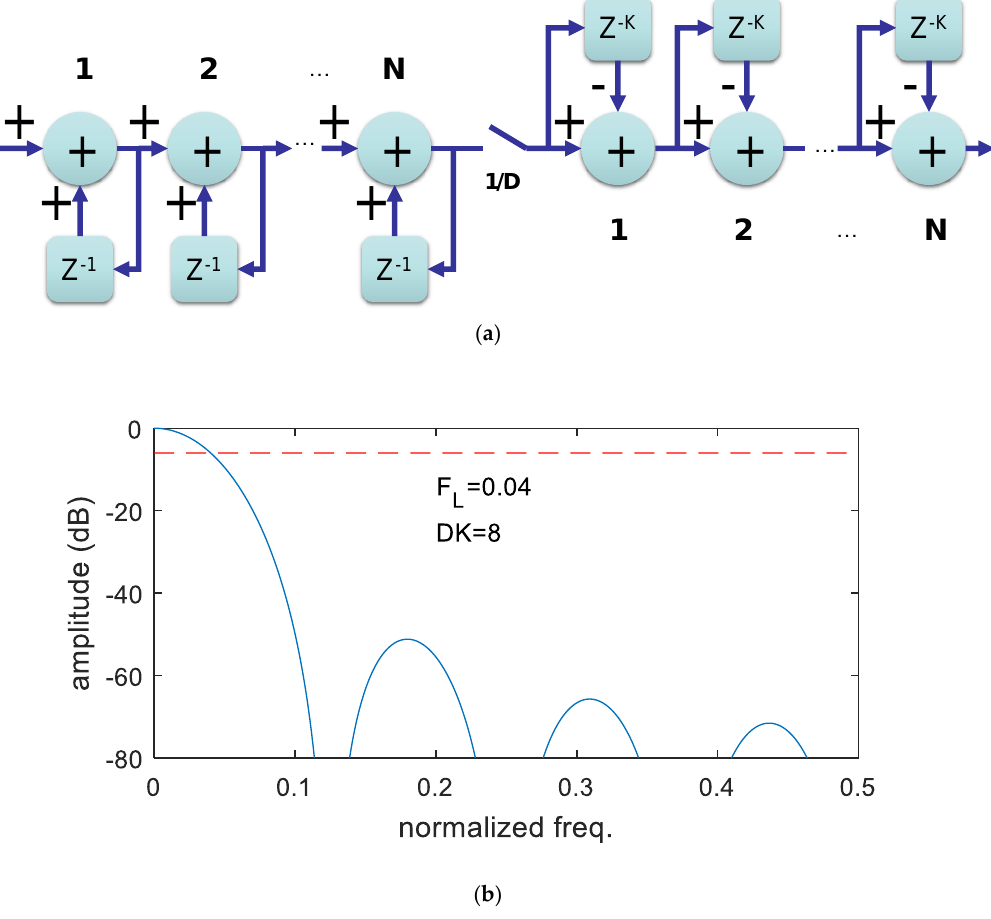
Figure 3. ( a ) 4-cell CIC filter and ( b ) an example of filter masks with DK = 8 for cut-off frequency F L = 0.04. Horizontal dashed line represents the −6 dB level.